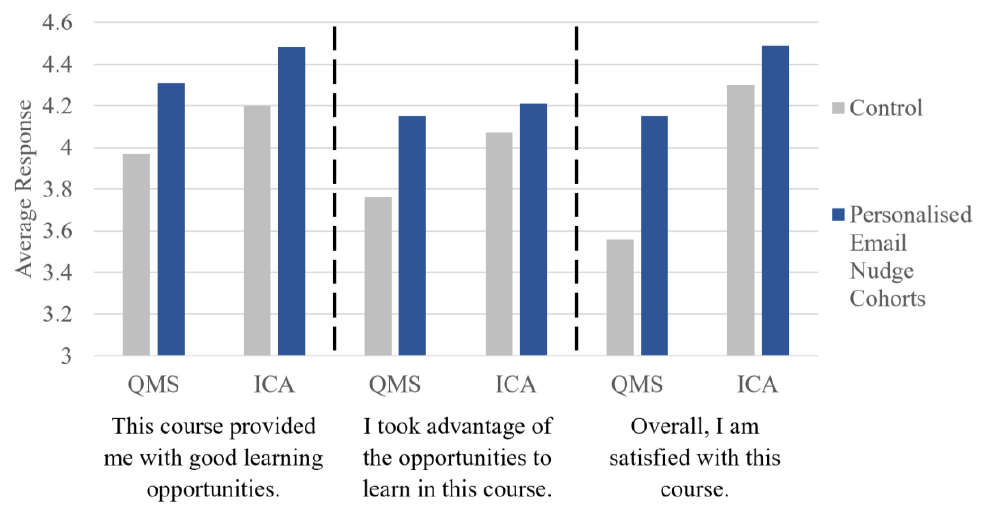
Figure 2 Average Likert Item Responses (1=strongly disagree and 5=strongly agree) for Quantitative Methods in Science (QMS) and Introductory Calculus and Algebra